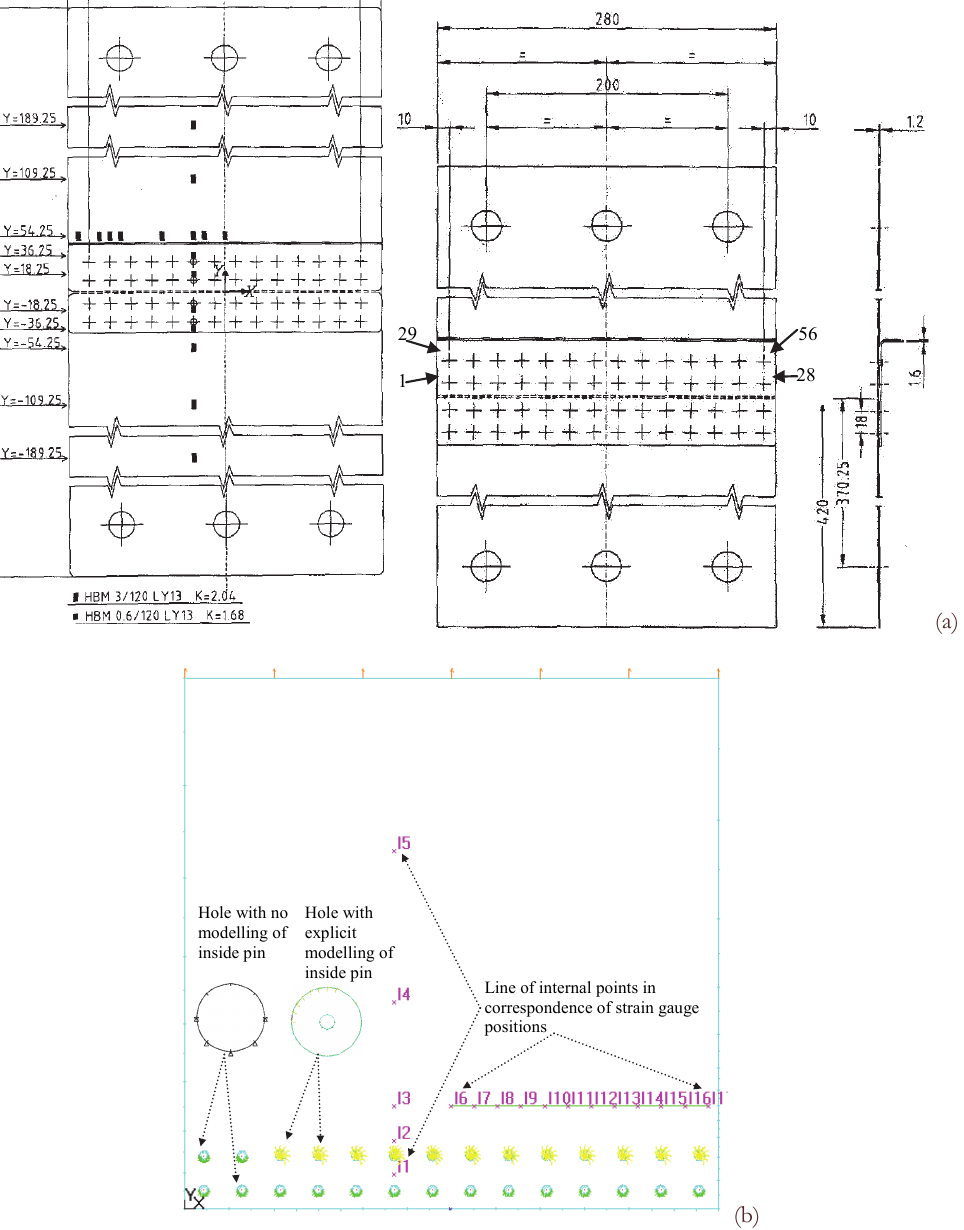
Figure 2: Butt joint sketch (a) with highlight of strain gauge positions and crack tip numbering (N. 1:28 in the lower hole row and N. 29:56 in the upper cracked hole row); DBEM uncracked model (b) with highlight of internal spring (yellow symbols), internal points and hole constraints (green